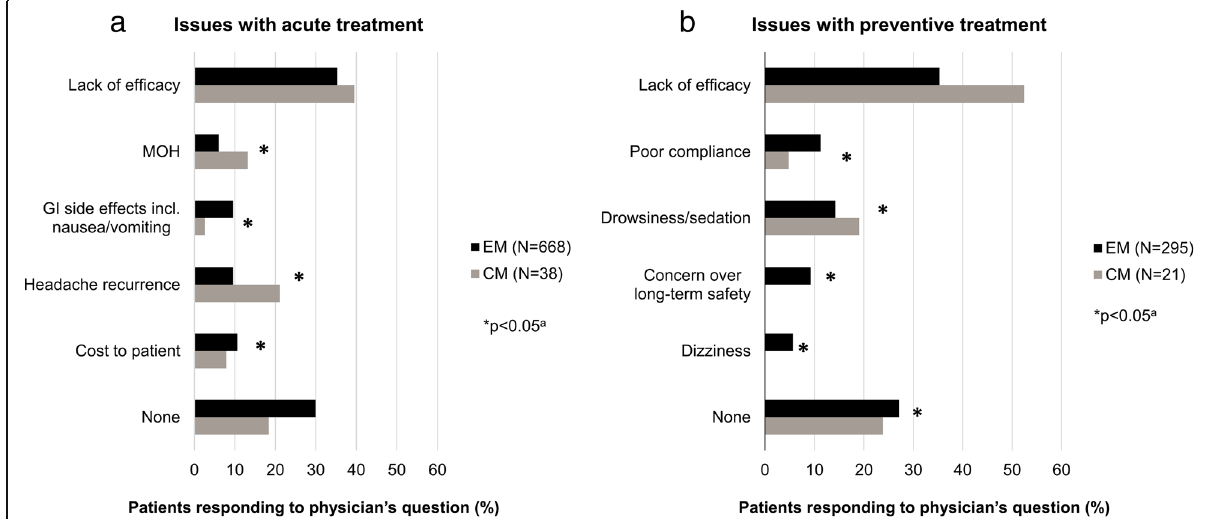
Fig. 2 Issues with ( a ) acute and ( b ) prophylactic treatment reported for > 5% of patients with episodic migraine (EM) and chronic migraine (CM): physician-reported data. Issues were selected from a predetermined list by physicians when patients responded to the question “ Any issues with acute/preventive regimen? ” . An item was checked only if considered an issue by the physician. Data were not available for all patients (either unknown or patient was not receiving treatment). Percentages are calculated as proportion of patients receiving acute therapy who reported at least one issue with therapy (acute treatment: EM, N =668; CM, N =38, total, N =706; preventive treatment: EM, N =295; CM, N =21; total, N =316). “ None ” indicates the physician noted the patient had no acute/preventive treatment issues in the “ other ” category. GI, gastrointestinal;